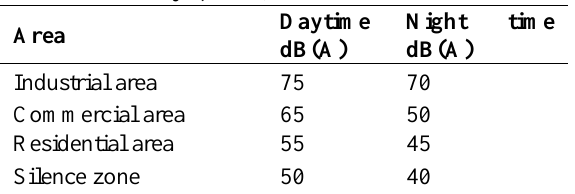
Ambient air quality standards in respect of noise by (CPCB) (Khitolya, 2007 )